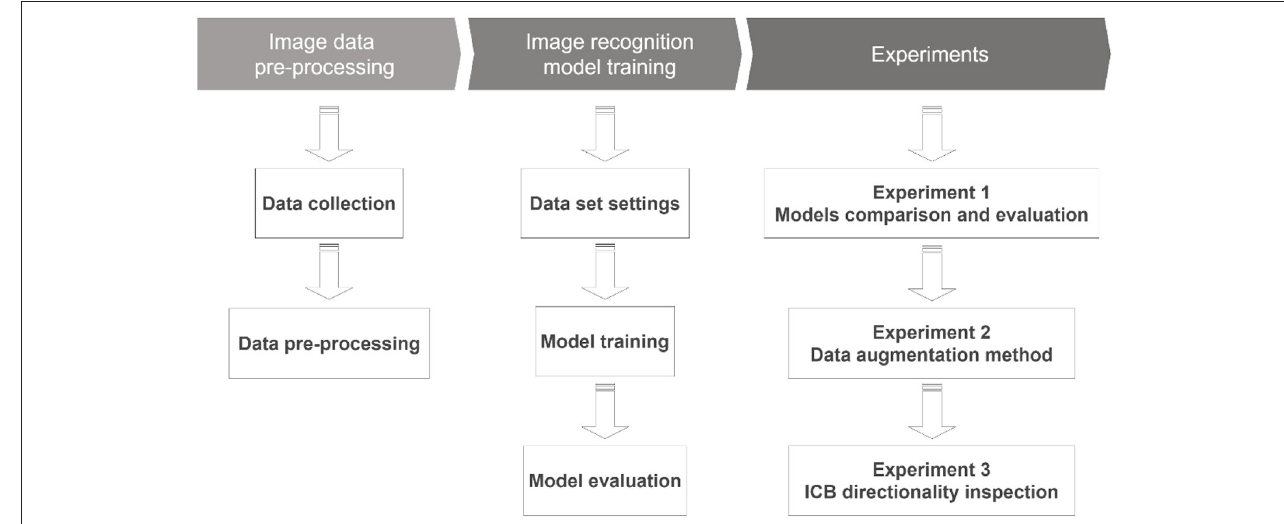
FIGURE 3 | Research flow